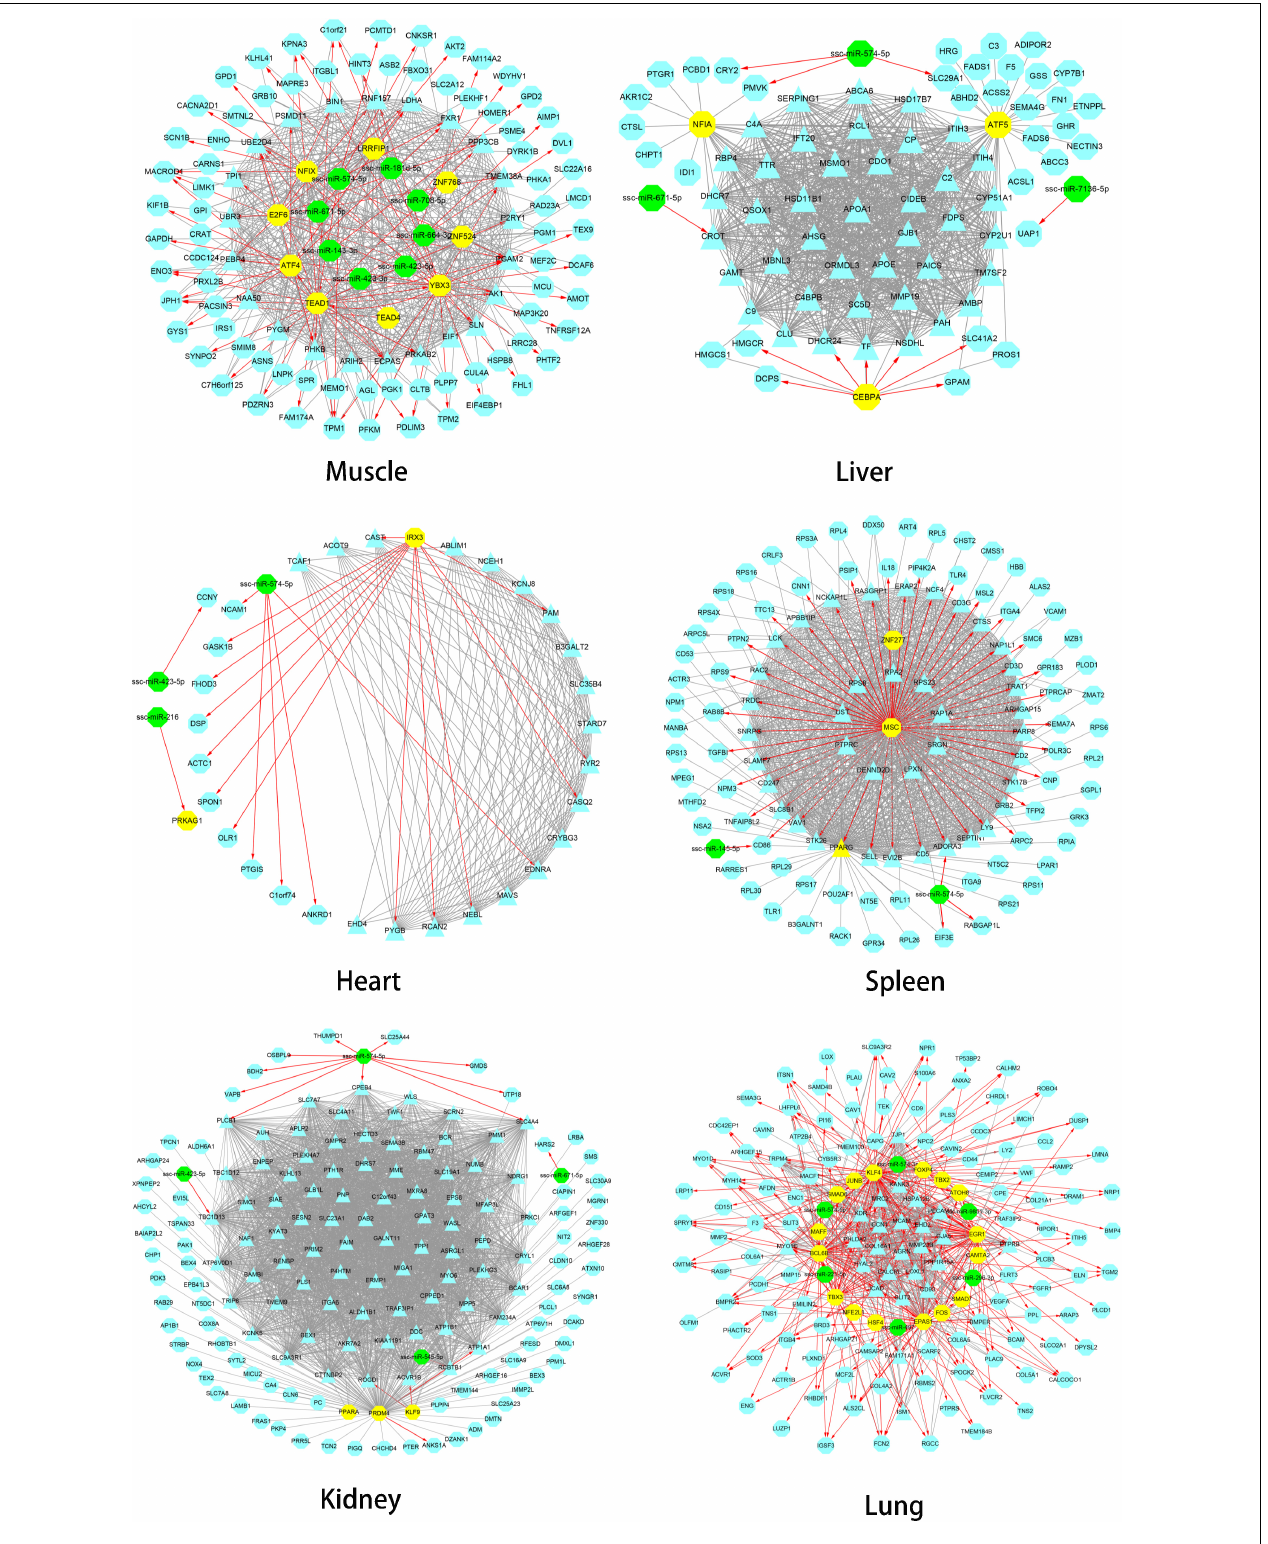
FIGURE 5 | Gene regulatory network of six tissues of Tibetan pigs. In each network in the figure, the yellow dots represent TFs, the green dots represent miRNAs, and the hub genes are represented by triangles. The red edges with arrows represent the regulatory relationship between TFs and miRNAs and target genes. The gray edge indicates that there is only a co-expression relationship between the two